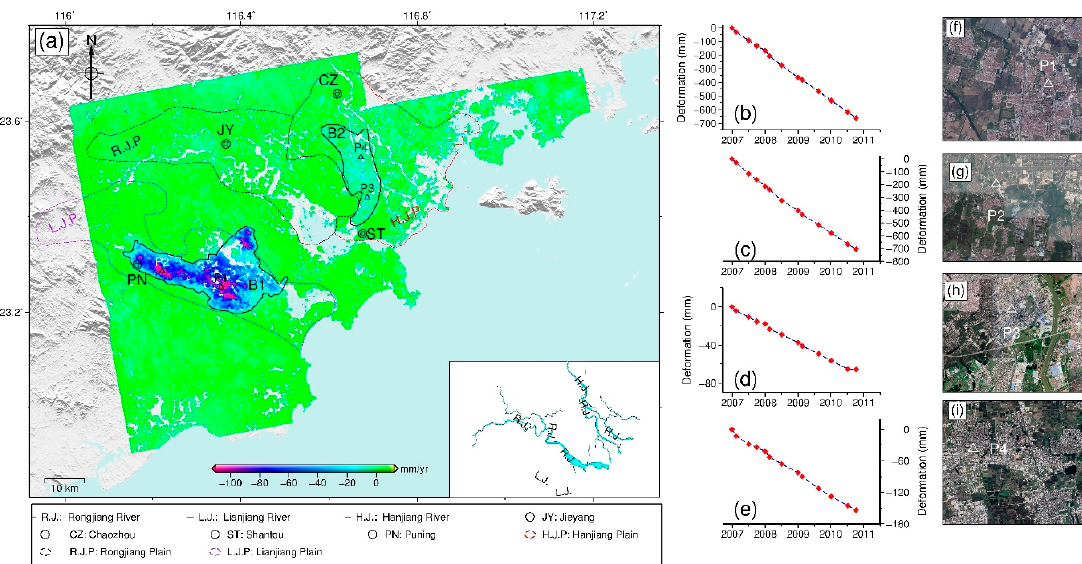
Figure 10. ( a ) Average surface deformation map of the Chaoshan Plain (CSP). Black solid circles B1 and B2 are two primary subsidence bowls with notable deformation rates. Purple, black and red dotted circles represent the Lianjiang Plain, Rongjiang Plain, and Hanjiang Plain, respectively. Cyan filled lines in the inset indicate the three primary rivers, the Lianjiang River (L.J.), Rongjiang River (R.J.) and Hanjiang River (H.J.). P1 to P4 are four selected points located in the mixed agricultural and urban land areas. ( b – e ) are the corresponding time series of the four selected points. ( f – i ) are the corresponding optical images for the four points.